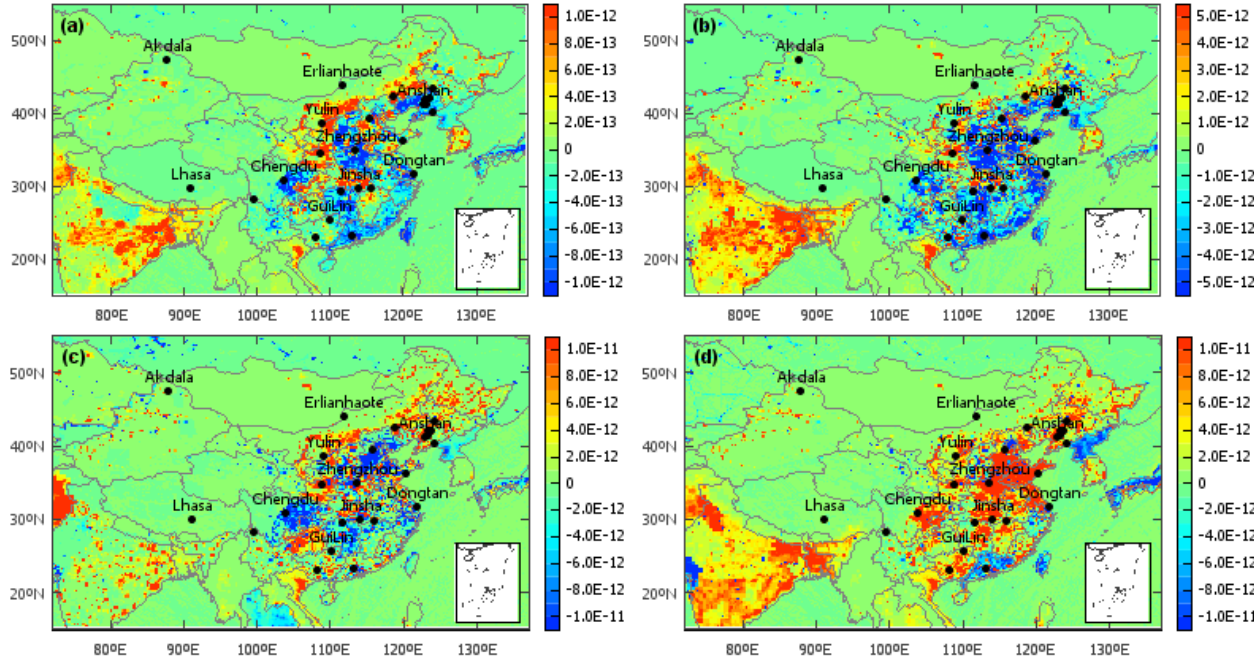
Figure 9. Emissions differences between 2010 and 2008 at a resolution of 0 . 1 ◦ × 0 . 1 ◦ , based on HTAP_v2 data set: (a) BC; (b) PM 2 . 5 ; (c) SO 2 ; (d) NO x (units: kgm − 2 s − 2